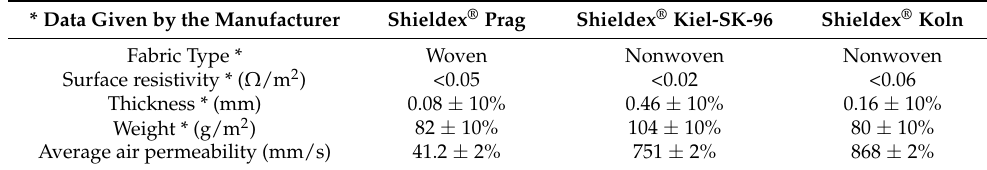
Table 1. Properties of the conductive materials Shieldex ® * data given by the Shieldex ® Prag Shieldex ® Kiel-SK-96 manufacturer Fabric Type *